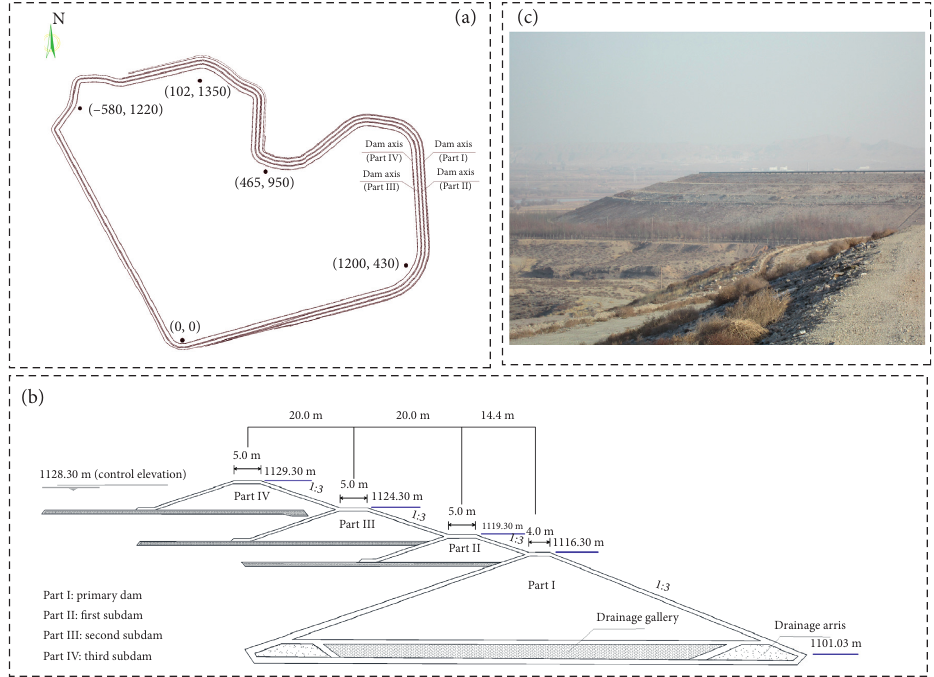
Figure 1: Schematic diagram and photo of the ash storage site. (a) The planar graph, (b) the cross-sectional graph, and (c) the photo of the ash storage field. Table 1: Stratum of the ash storage